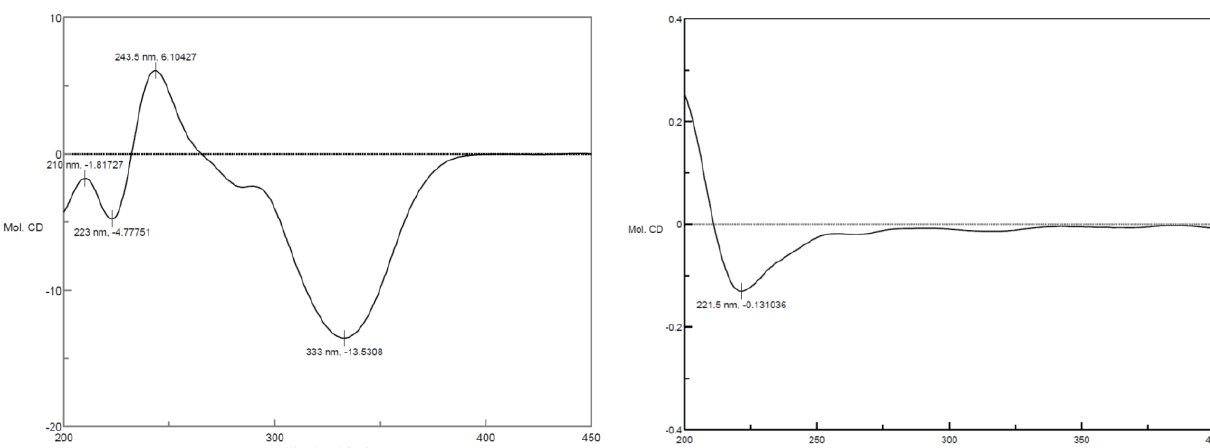
Figure 3. CD spectra of compound 1 and danshensu.